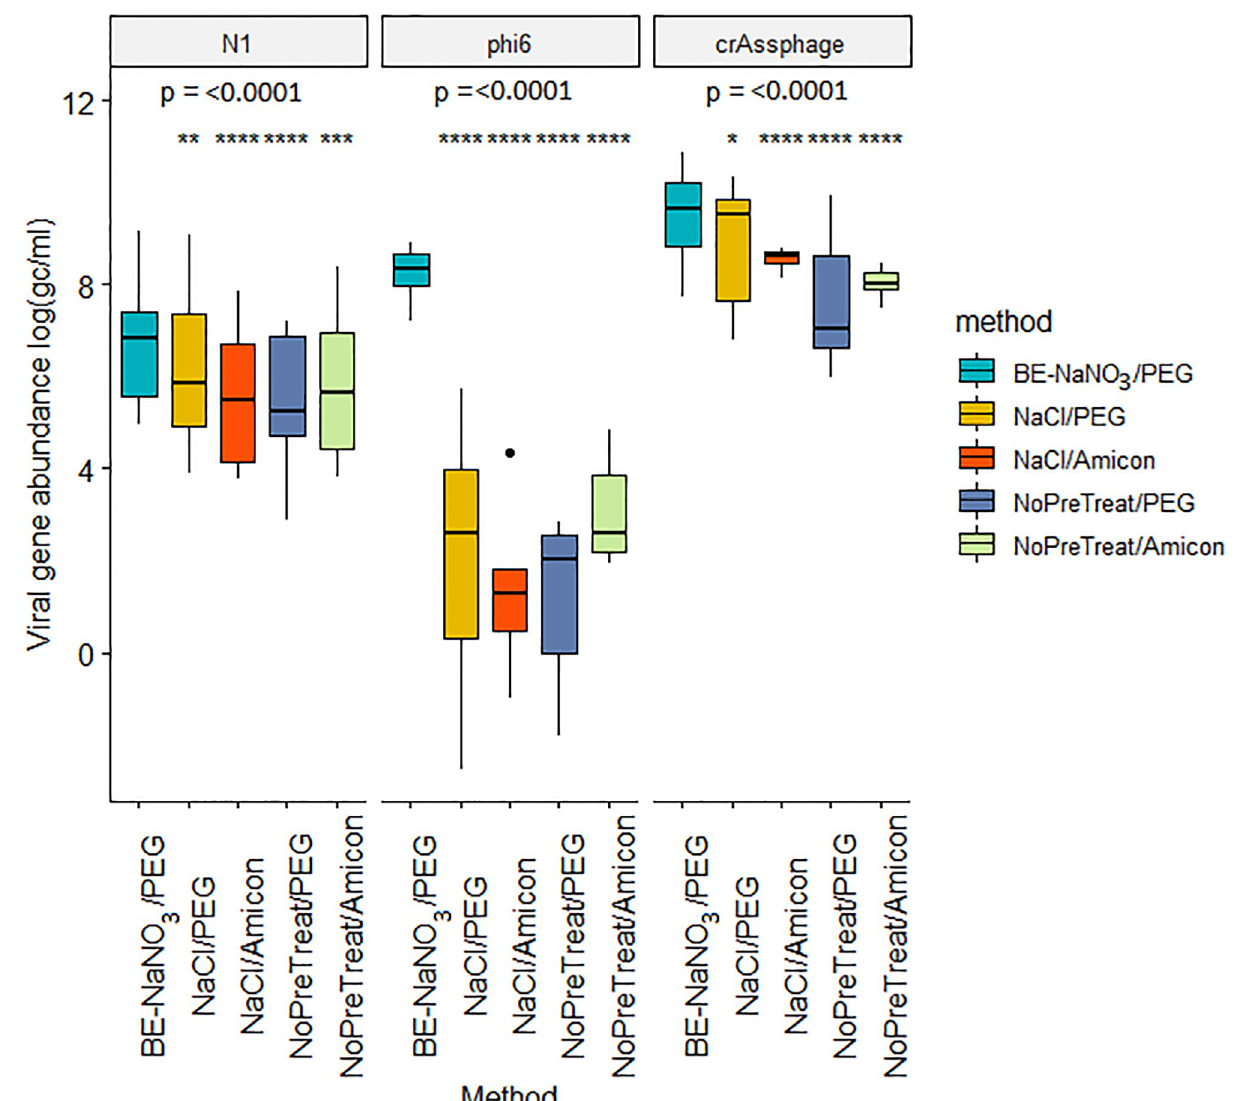
Fig 2. Boxplots showing the viral gene abundance recovered for N1, phi6 and crAssphage with different processing methods of spiked wastewater. Global p-value is shown for each target, and significance codes ( � 0.0001 ‘ ���� ’, � 0.001 ‘ ��� ’, � 0.01 ‘ �� ’, � 0.05 ‘ � ’) indicate statistically significant difference in results of BE-NaNO 3 /PEG methods compared to each of the remaining